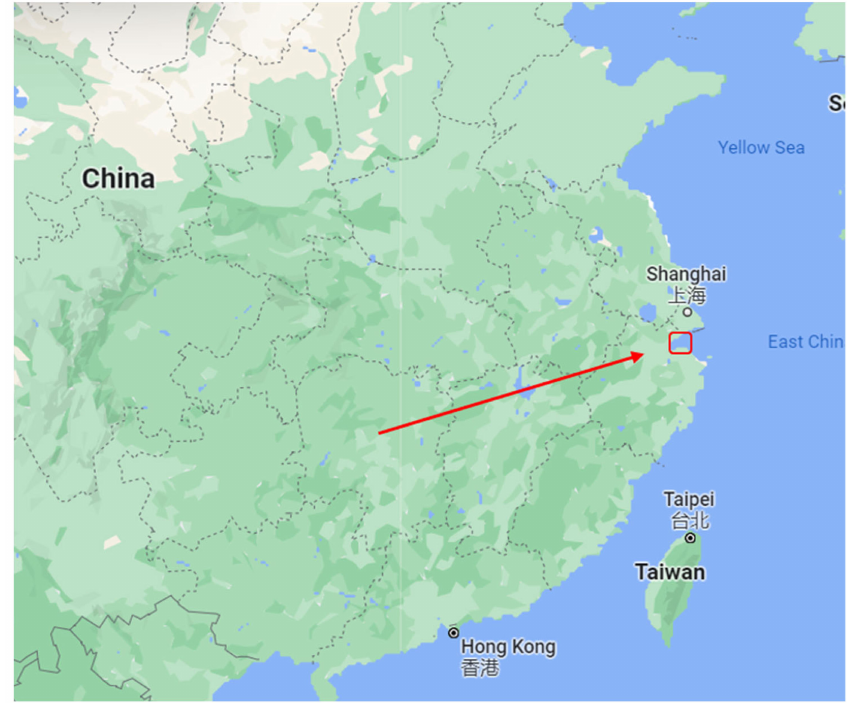
Figure 1. Specific locations of the study area in